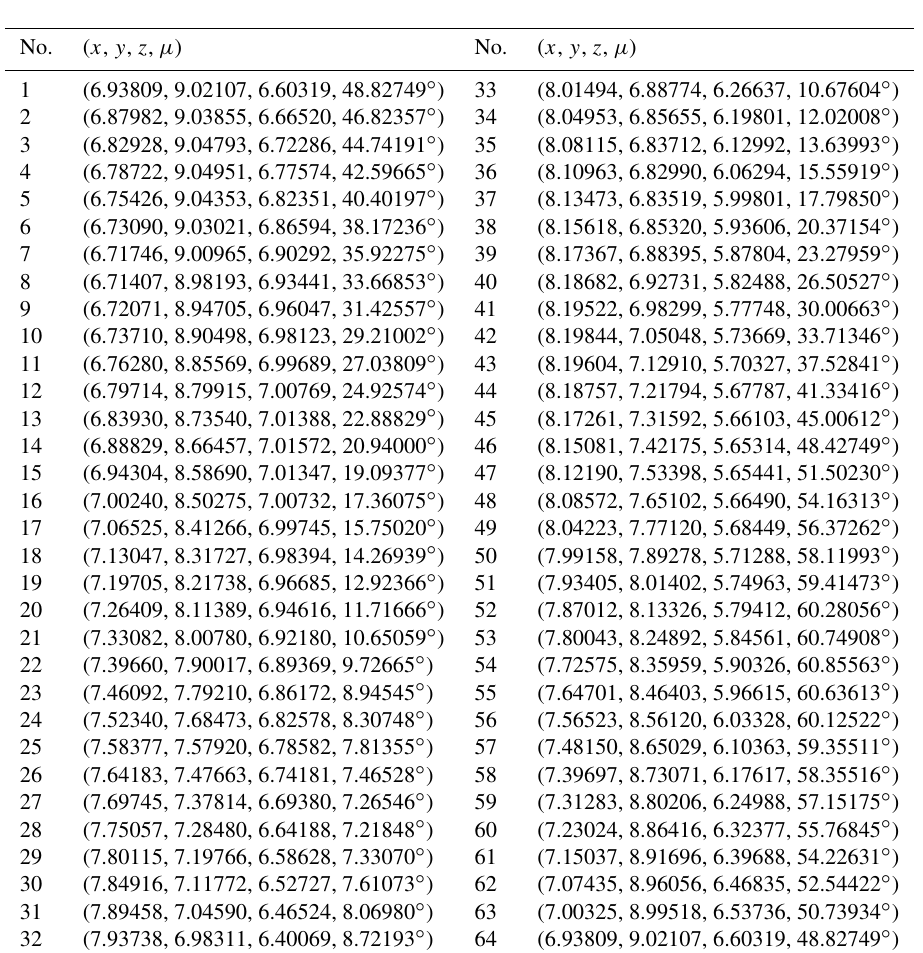
Table 3. The prescribed position and orientation.